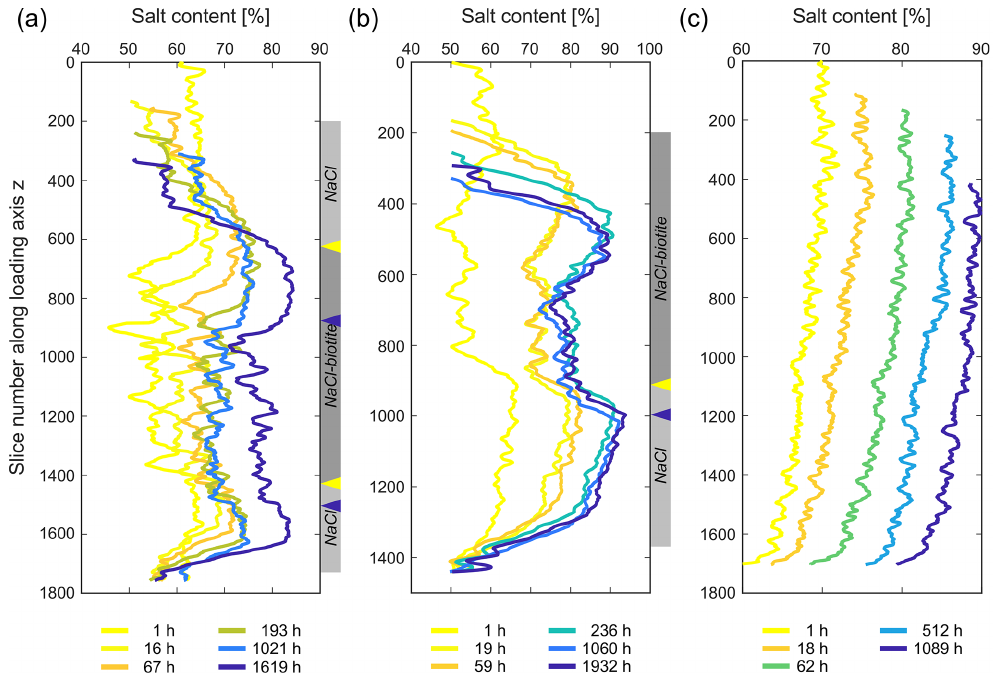
Figure 14. Evolving NaCl distribution in (a) the SBS, (b) the SB and (c) the pure NaCl sample with progressing deformation. The NaCl content was measured in 2-D for each slice along the loading axis. Panels (a) and (b) show that the NaCl content in the biotite-bearing layer increases more than in the rest of the sample, while panel (c) shows a homogeneous increase of the NaCl content within the sample. Note that the arrows on the side mark the position of the interface between the biotite-bearing layer and the pure NaCl layer, with their colours corresponding to the time steps as indicated in the key below. The grey bar reflects the sample composition at the initial compaction